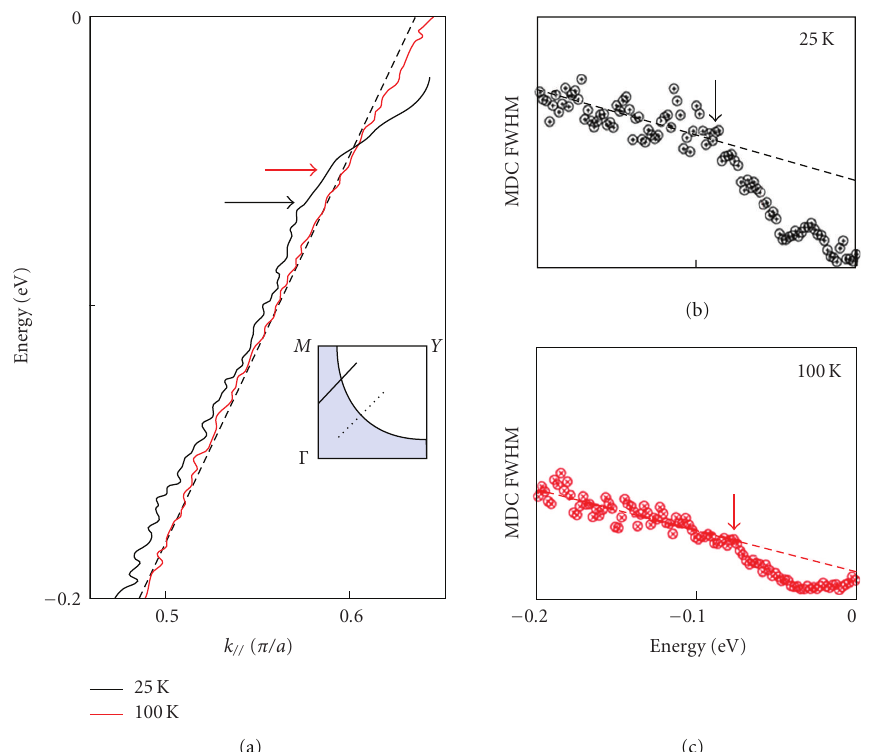
Figure 4: ARPES MDC dispersion data taken optimally doped Bi 2 Sr 2 CaCu 2 O 8+ δ ( T c = 92 K) as discussed in [16]. Near antinodal point data (see inset) comparing (a) dispersion and (b-c) FWHM showing that the ARPES kink energy is shifted to lower energy when passing above T c . The MDC FWHM is related to the Im Σ ( k , ω